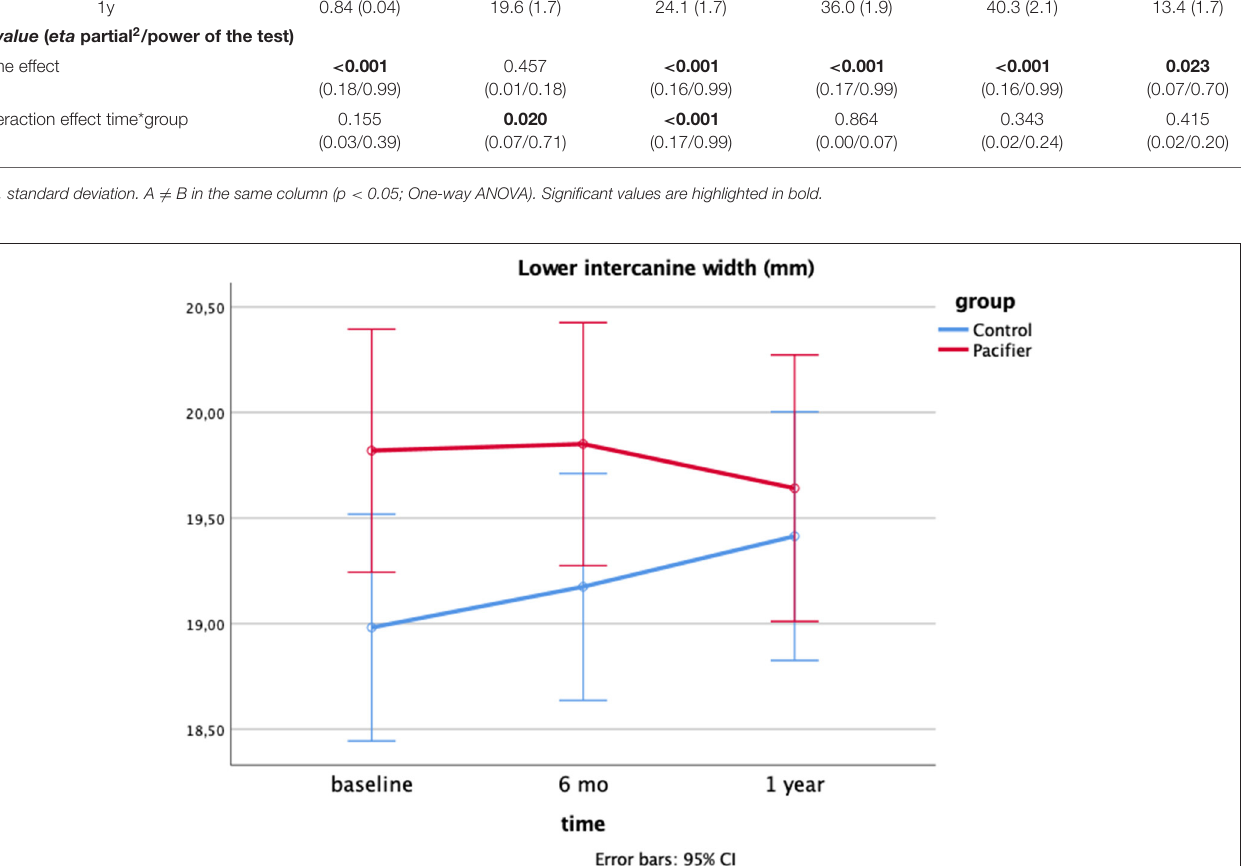
between groups was absent after 1-year of follow-up, as observed in Figure 2